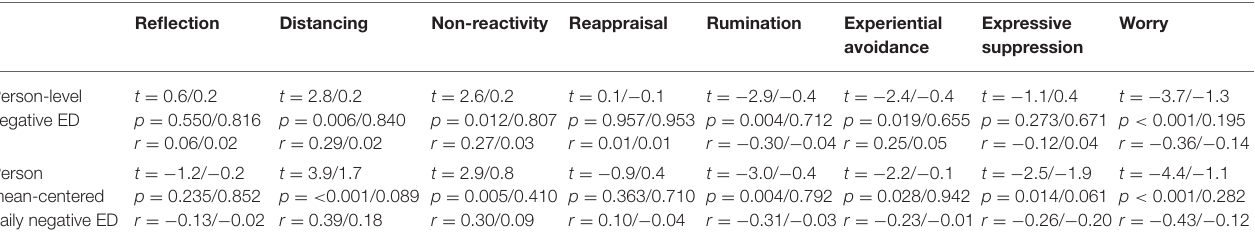
TABLE 6 | Results from separate multilevel models evaluating the association between daily emotion regulation strategies as a continuous measure and person-level and person mean-centered daily negative emotion differentiation (ED) (without/with daily negative emotions as a covariate). Reflection Distancing Non-reactivity Reappraisal Rumination Experiential